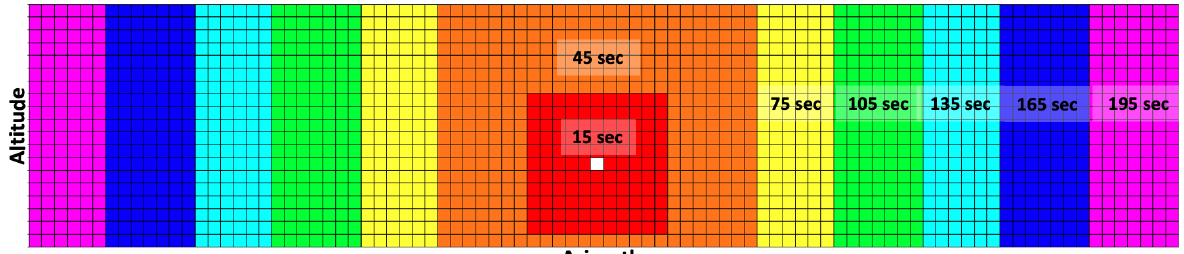
Figure 3. Discretized observation space and RSO propagation time used to account for varying action slew